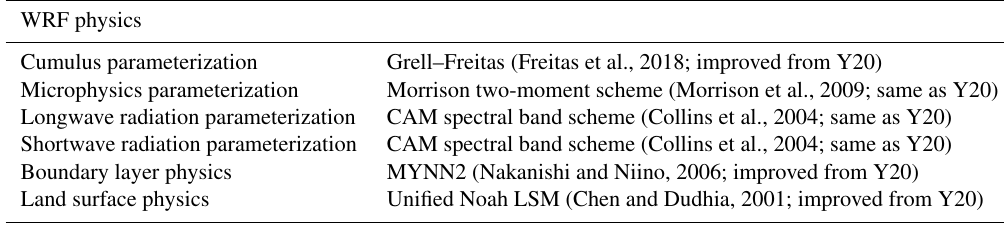
Table 1. The summary of physic parameterizations used in the Y21_CRTL experiment. WRF physics Cumulus parameterization Grell–Freitas (Freitas et al., 2018; improved from Y20) Microphysics parameterization Morrison two-moment scheme (Morrison et al., 2009; same as Y20) Longwave radiation parameterization CAM spectral band scheme (Collins et al., 2004; same as Y20) Shortwave radiation parameterization CAM spectral band scheme (Collins et al., 2004; same as Y20) Boundary layer physics MYNN2 (Nakanishi and Niino, 2006; improved from Y20) Land surface physics Unified Noah LSM (Chen and Dudhia, 2001; improved from Y20) ROMS physics Tracer advection scheme MPDATA (Smolarkiewicz, 2006; same as Y20) Tracer vertical mixing scheme GLS (Umlauf and Burchard, 2003; same as Y20) Bottom drag scheme Quadratic bottom friction (QDRAG; same as Y20) CICE physics Ice dynamics EVP (Hunke and Dukowicz, 1997; improved from Y20) Ice thermodynamics Bitz and Lipscomb (1999; same as Y20) Shortwave